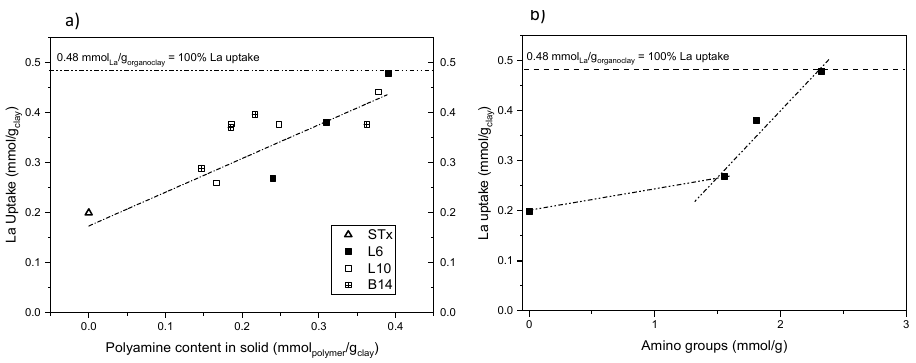
Figure 9. - La uptake as a function of ( a ) the polyamine content for the di ff erent organo-clays and ( b ) number of amino-groups (STx-L6 and STx-L10). Dashed lines are drawn as guide for the